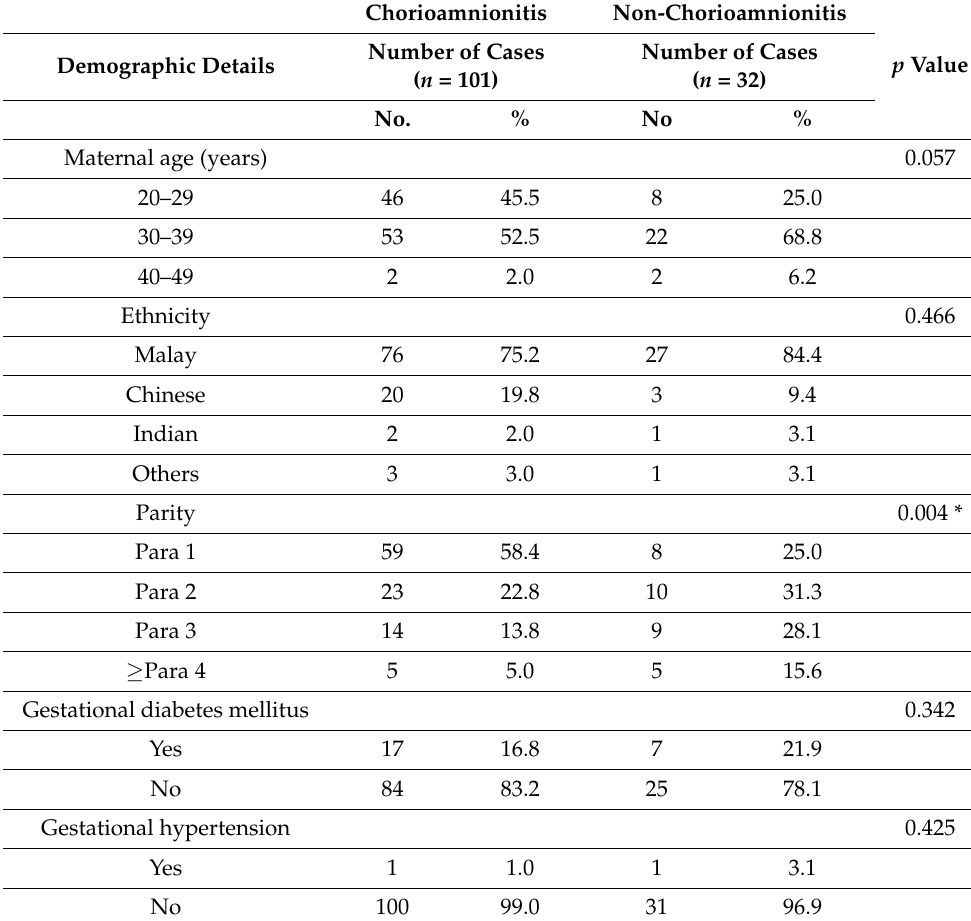
Table 1. Demographic data of subjects with and without chorioamnionitis in this study.